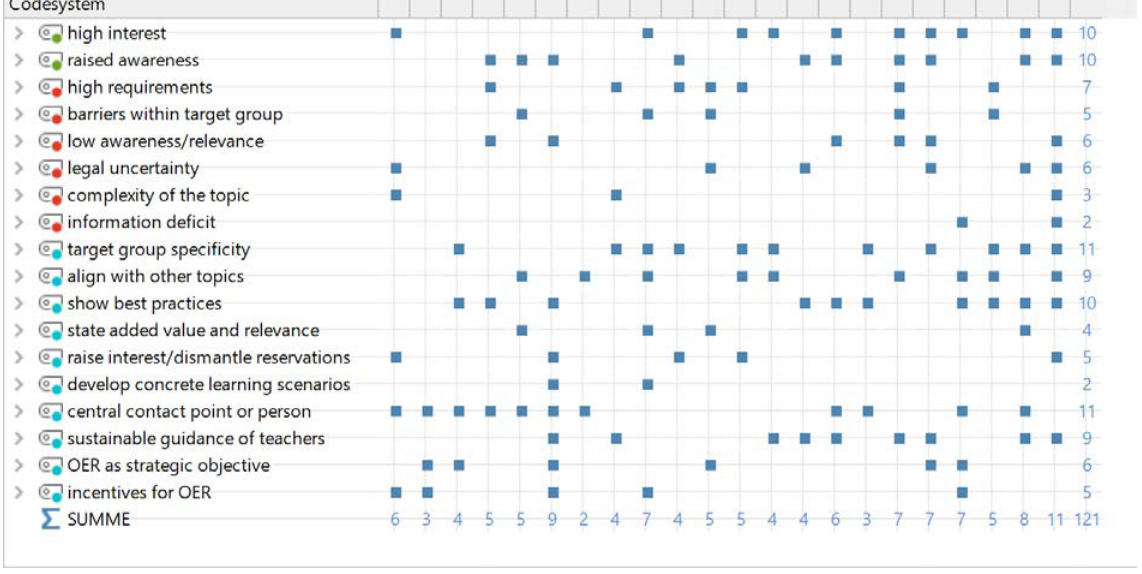
Figure 1. Overview of the coding for the meta-analysis. Each code in Figure 1 represents the highest level of aggregation and describes all other codes subsumed under it. The green and red flagged codes refer to the projects’ (positive and negative) lessons